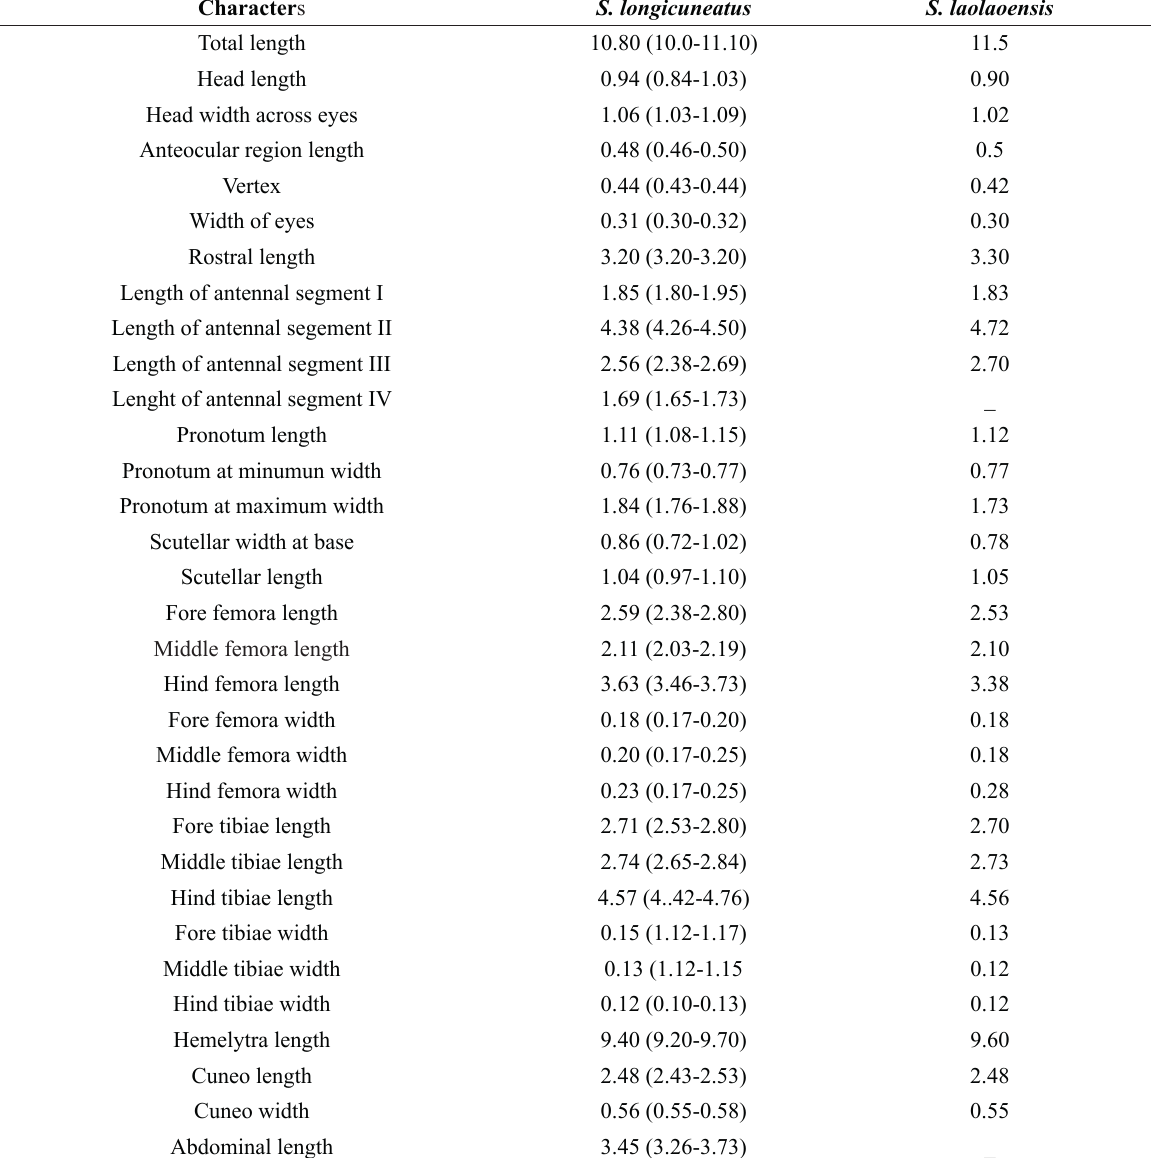
Measurements (mm.) of Stenodema longicuneata (Carvalho and Rosas, 1966) and Stenodema laolaoensis (Carvalho,